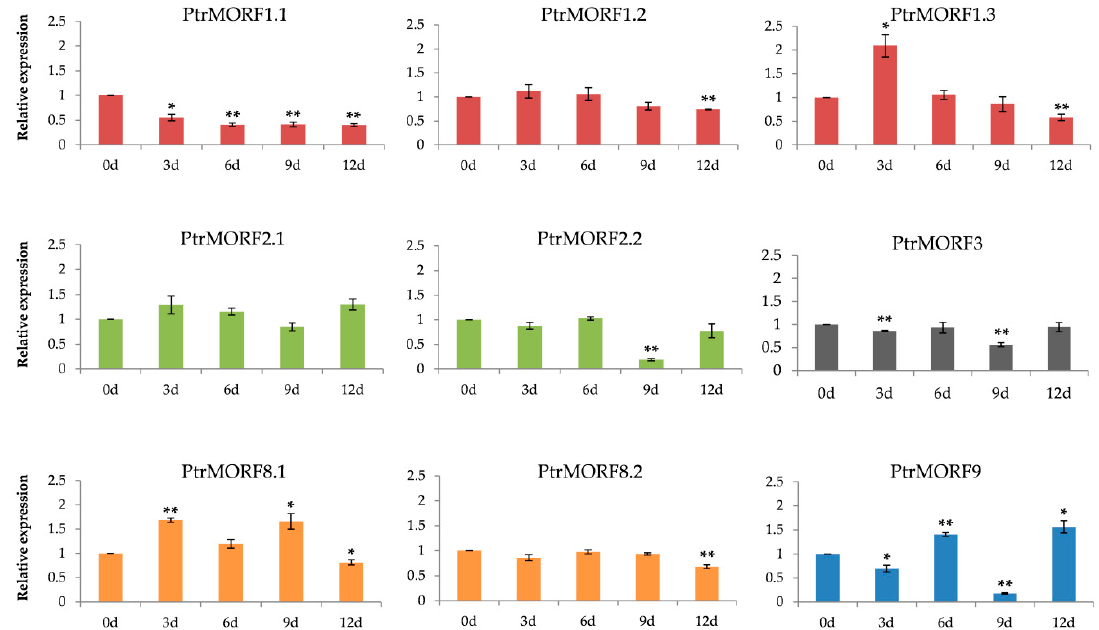
Figure 7. Quantitative RT-PCR analysis of PtrMORF genes expression in response to drought stress. 0d, 3d, 6d, 9d, and 12d, drought for 0, 3 ,6, 9, and 12 days in a greenhouse environment, respectively. Data were normalized to UBQ gene. The sample without drought treatment was de fi ned as 1 in the figure. The data were presented as the mean ± SE of three separate measurements. Asterisks denote significant differences: * p < 0.05; ** p < 0.01.